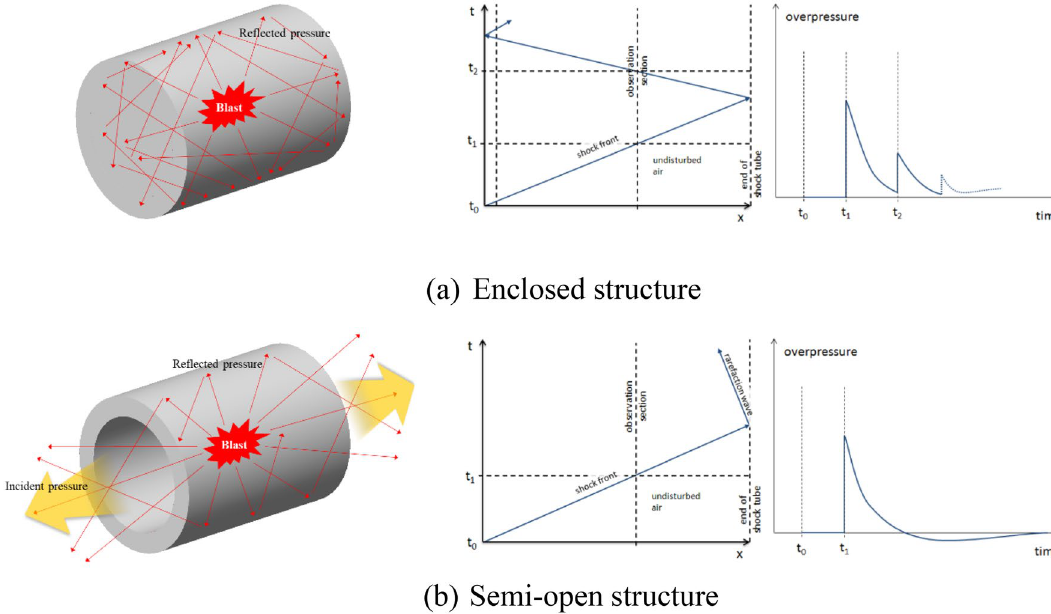
Figure 1. Schematic drawing of internal blast pressure propagation. ( a ) Enclosed structure. ( b ) Semi-open